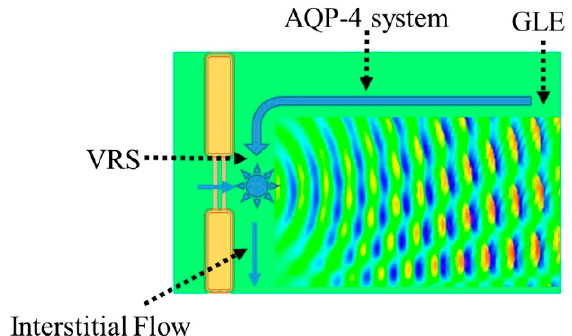
Figure 8. AQP-4 circulator model. The AQP-4 system provides additional water flow into peri-capillary VRS (thick blue arrow). Water enters astrocytes through AQP-4 at the GLE. This internal circulation further promotes appropriate interstitial fluid dynamics including flow through VRS (interstitial flow), otherwise known as glymphatic flow.